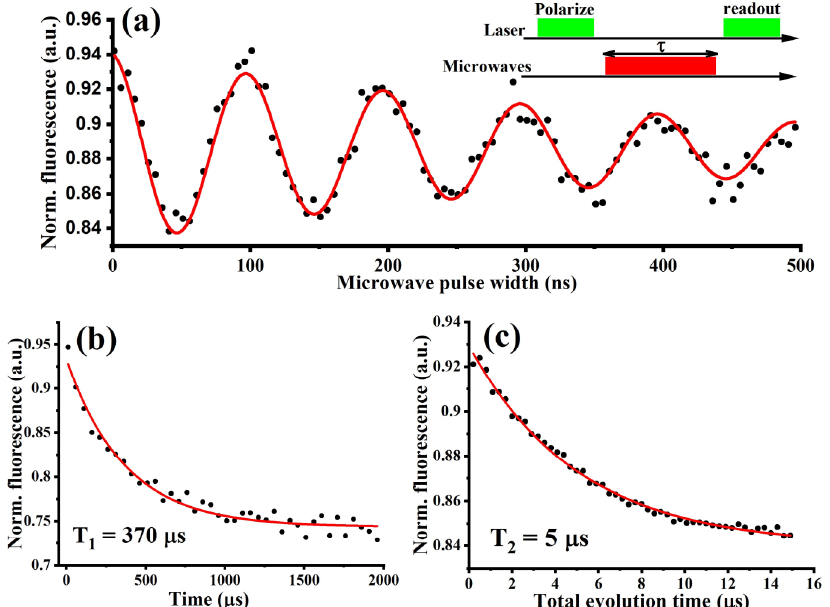
Figure 4. ( a ) The reported BNDs show clear Rabi oscillations between m s = 0 and m s = ± 1 states. ( b ) longitudinal relaxation time T 1 of the NV center. ( c ) The NV center spin coherence time (T 2 ) measure using Hahn-echo pulse